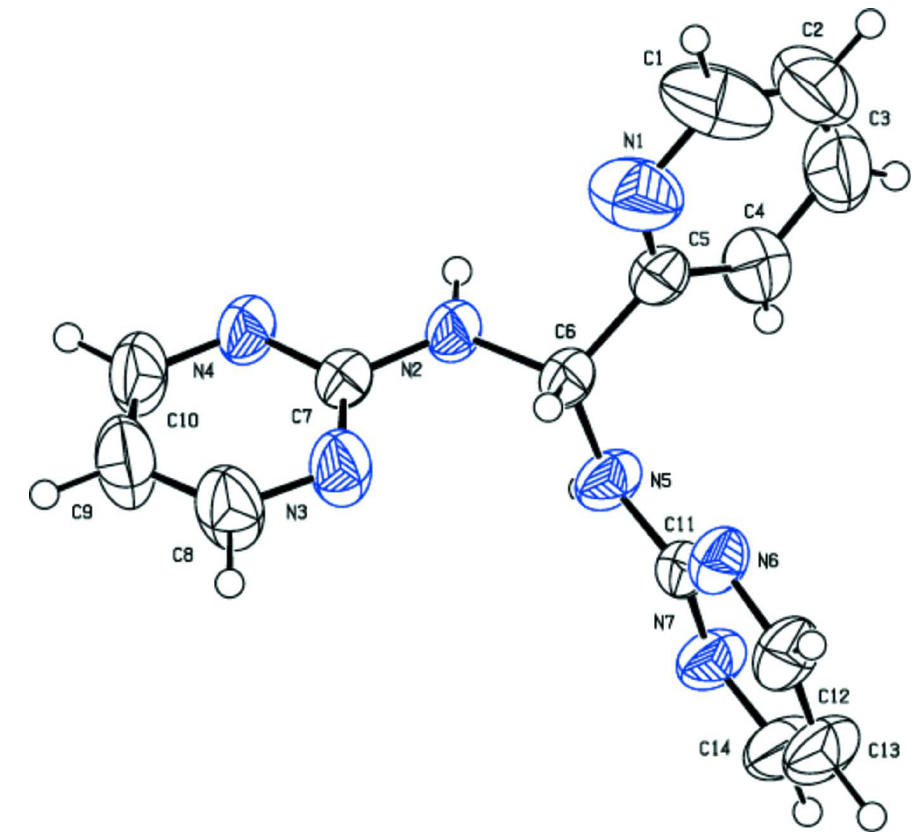
Figure 1 The molecular structure of (I). Displacement ellipsoids are drawn at the 50% probability